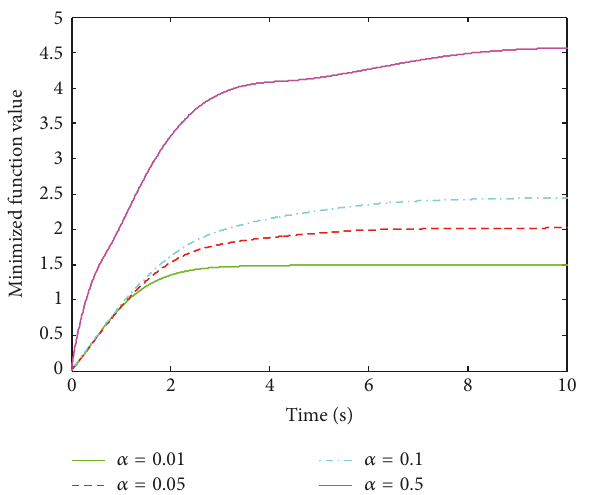
Figure 6: Minimized function value 𝐽 ∗ with different